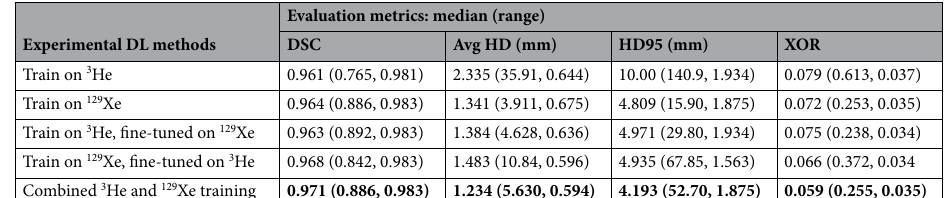
Experimental DL